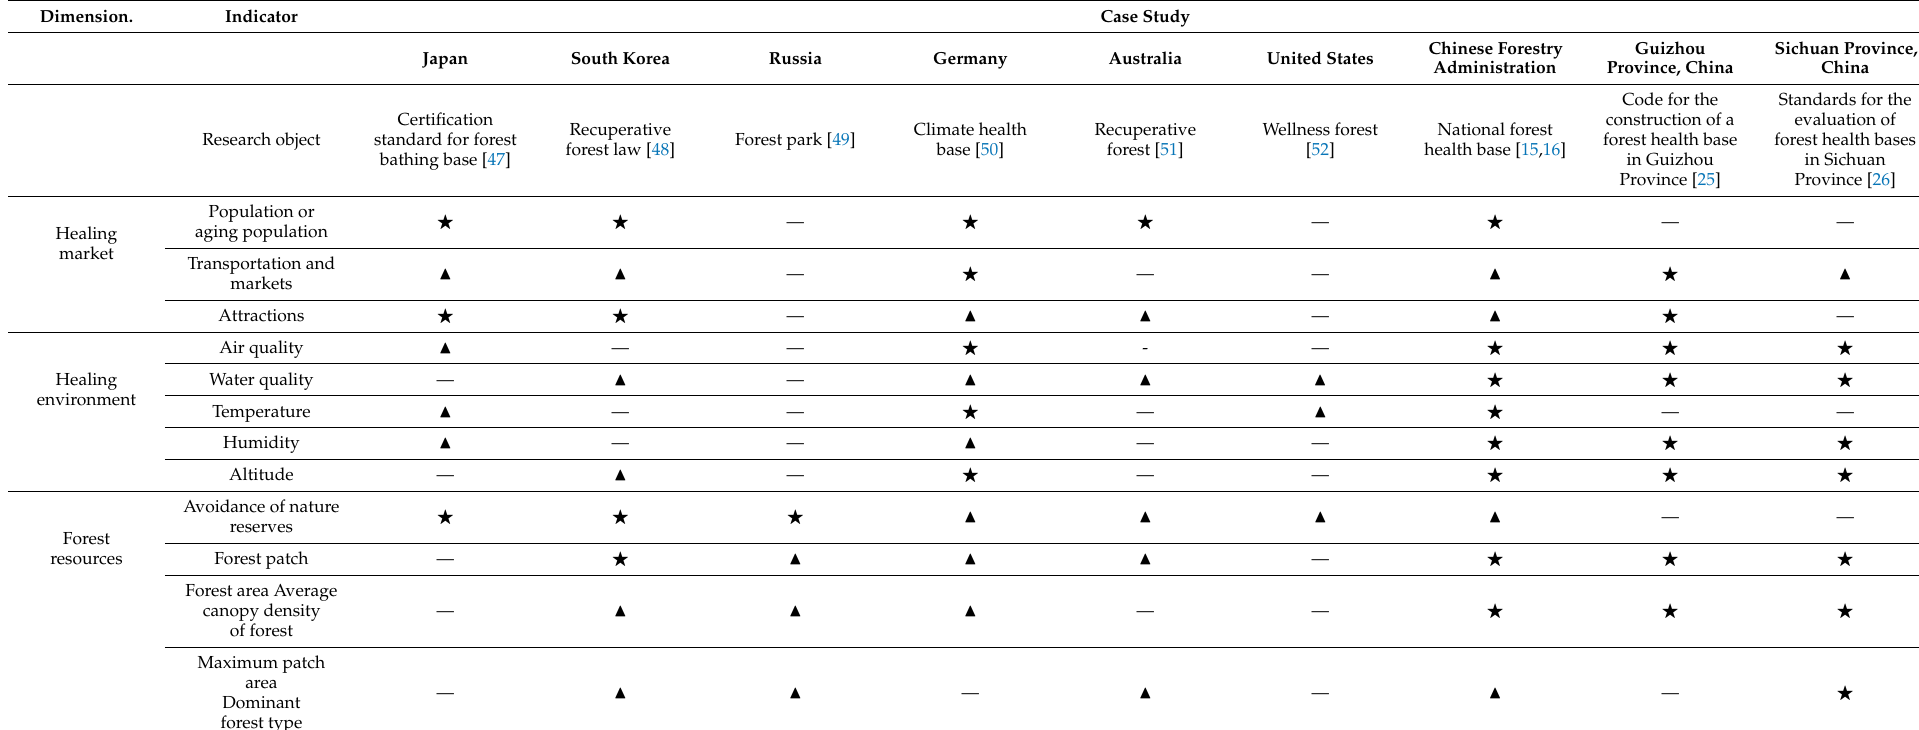
Table 1. A summary of the research standards for the site selection of FHBs.